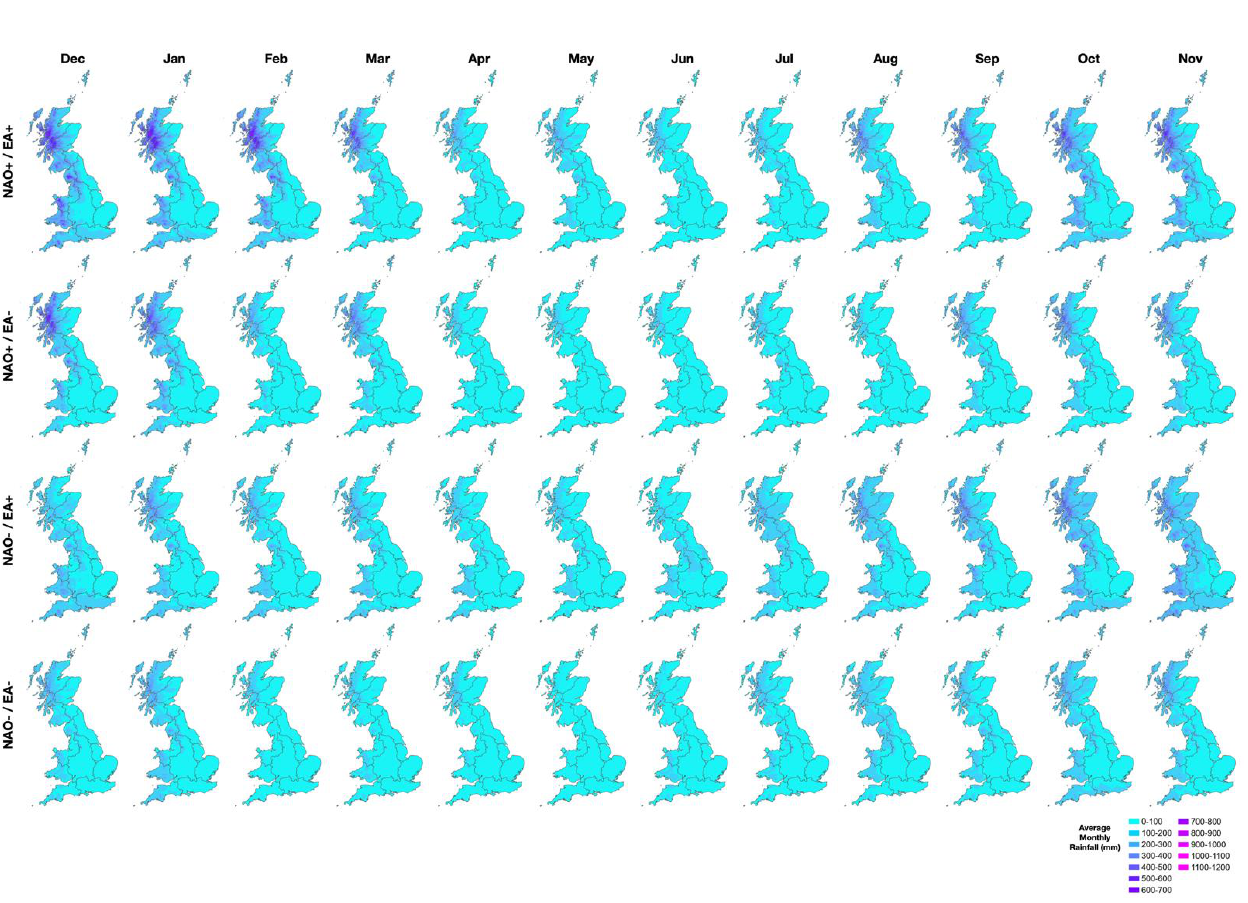
Figure A1. Maps of average monthly rainfall (based on the CEH GEAR dataset) under different phase combinations of the NAO and EA.